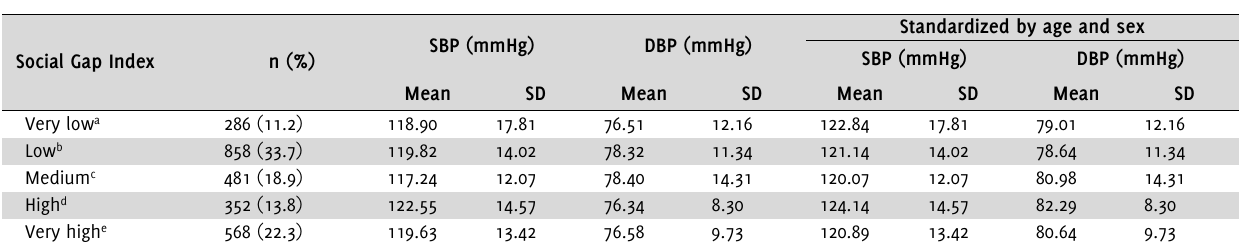
Table 3. Mean Blood Pressure by Social Gap Index, Before and After Standardization by Age and Sex.